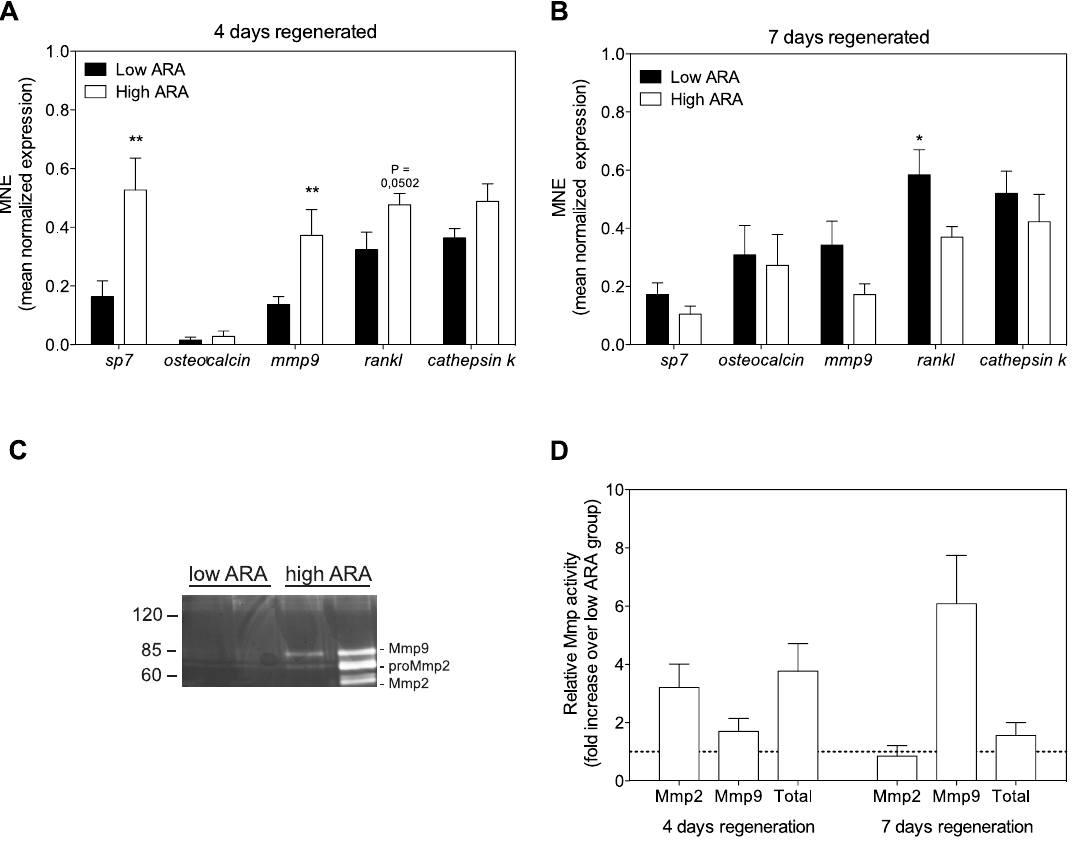
Figure 5. Gene expression profile and Mmp activity of regenerating scales of fish fed the different diets. A : Gene expression of sp7 and rankl (osteoblast), as well as mmp9 (osteoclast) is higher in the high ARA group compared to the low ARA group in 4-day-old regenerating scales. B : After 7 days of scale regeneration, these differences mostly disappeared. Gene expression of the low ARA group has increased compared to expression levels at day 4 and expression of rankl is also significantly higher compared to the high ARA group. Gene expression is shown as mean normalized expression (MNE). MNE for scales obtained from fish fed the ARA-restricted diet (low ARA) are shown with black bars and for scales from fish fed the ARA-enriched diet (high ARA) with white bars. Bars represent the mean 6 SEM of 9 replicates. After assessment of normal distribution (D’Agostino & Pearson normality test), statistical analysis was done with either Student’s t -test, or Mann-Whitney U-test (* p , 0.05, ** p , 0.01). C : Enzymatic Mmp9 activity of 7-day-old regenerating scales is higher in the high ARA group, as seen on gelatin zymography. Protein mass ladder is depicted in kiloDalton (kDa). D : Semiquantitative analysis of enzymatic Mmp2 and Mmp9 activity and total Mmp activity in 4-day-old and 7-day-old regenerating scales shows the increased Mmp9 activity observed in ( C ). Mmp activity of scales from high ARA fish is expressed relative to those of low ARA fish analyzed on the same gel. Bars represent the mean of 4 samples; horizontal line represents the low ARA samples. One sample t -test was used to compare the mean Mmp activity to 1. P-values for 4 days regeneration: P=0.07 for Mmp2, P=0.22 for Mmp9 and P=0.06 for total. P-values for 7 days regeneration: P=0.72 for Mmp2, P=0.05 for Mmp9 and P=0.29 for total.